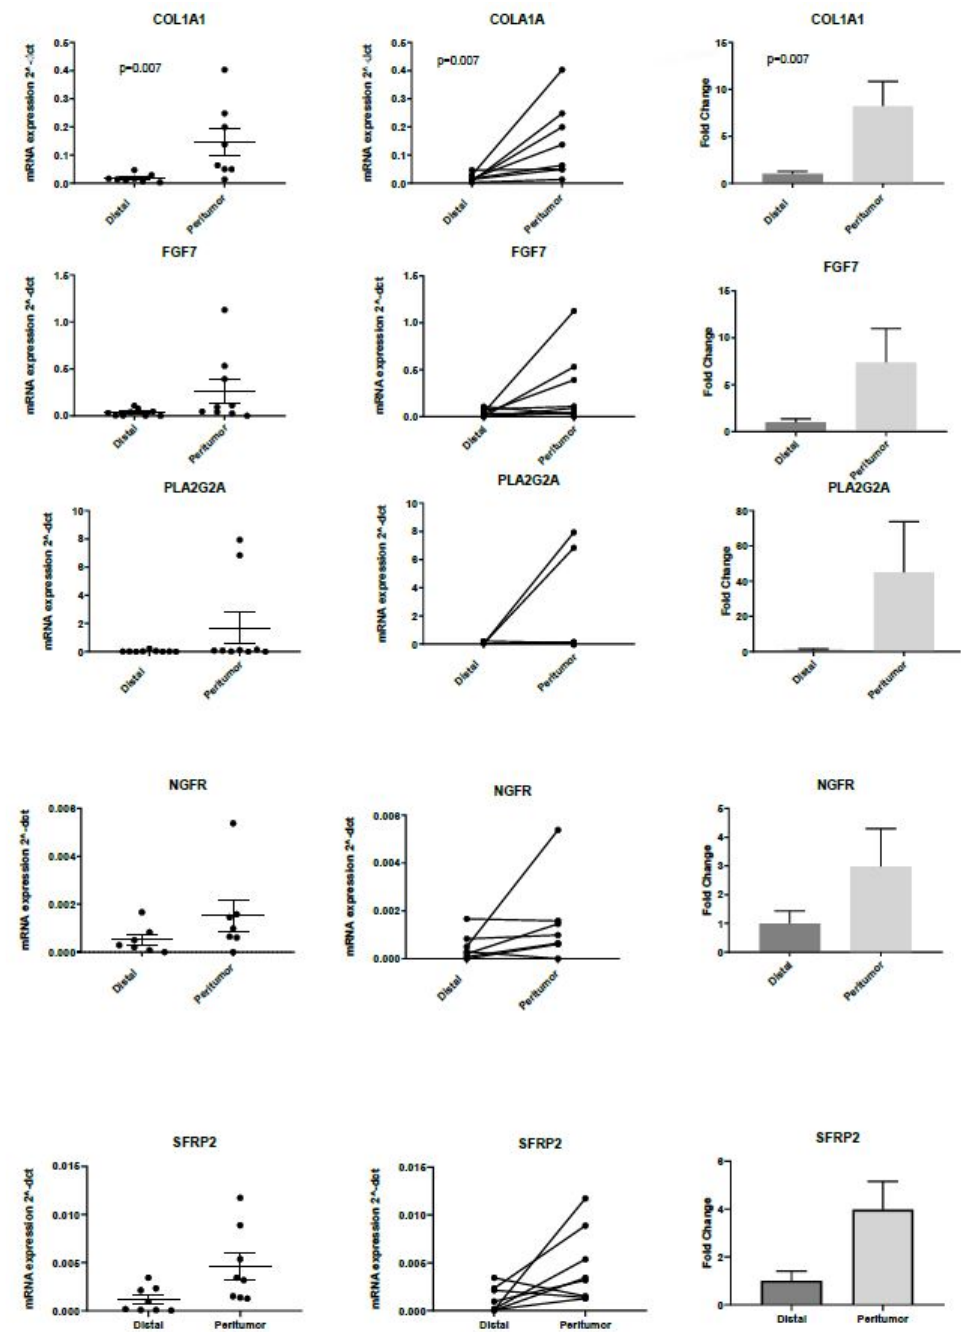
Figure 4. Validation of the 5 most significantly up-regulated genes identified with PanCancer pathway analysis. RT-PCR confirmed higher RNA expression of COL1A1 , FGF7 and SFRP2 in pAT compared to distal AT ( COL1A1 n = 8, p = 0.007; FGF7 n = 9, p = 0.05; PLA2G2A n = 9, p = 0.16; NGFR n = 7, p = 0.10; SFRP2 n = 8, p = 0.05